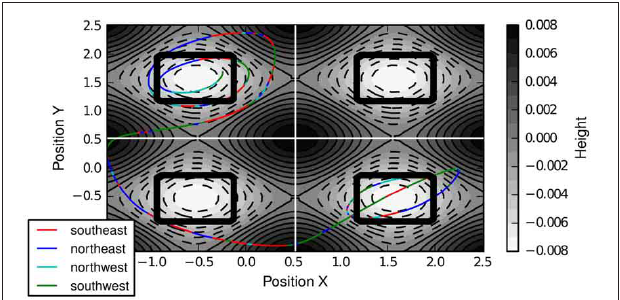
FIGURE 3 | 2D Multi-Valley domain. Gray-scale contours depict the height of the two-dimensional surface. The black boxes denote the target regions of the different tasks and the white lines the boundaries of the valleys. Shown is one example trajectory with color-coded